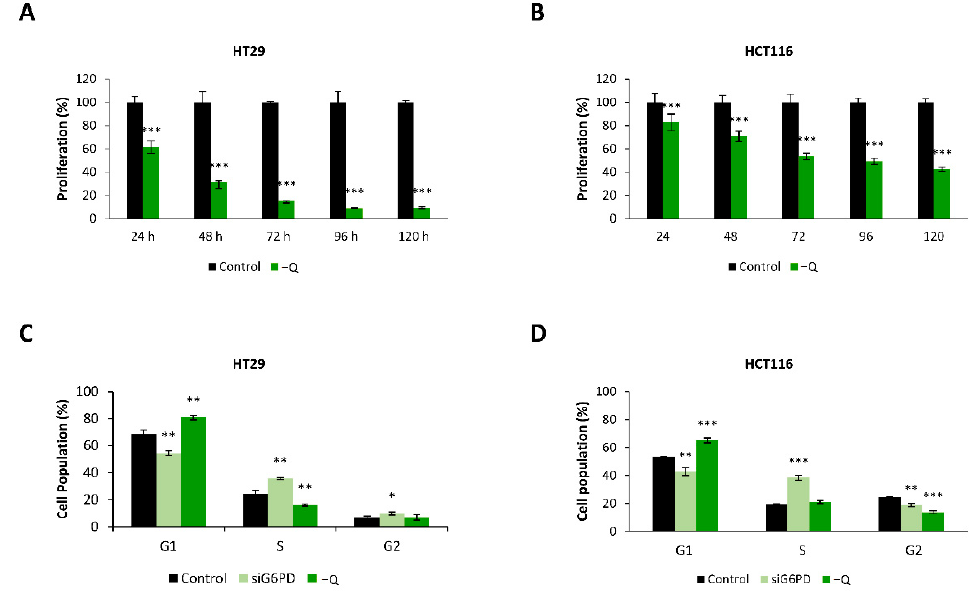
Figure 3. Glutamine deprivation decreased the proliferation of colon cancer cells and induced cell cycle arrest. ( A , B ) Proliferation rate of ( A ) HT29 cells and ( B ) HCT116 cells in control media and glutamine-free media ( − Q) at 24, 48, 72, 96, and 120 h. ( C , D ) Cell cycle distribution analysis of ( C ) HT29 and ( D ) HCT116 cells 96 h after transfection against G6PD or glutamine deprivation. The percentage of cells in the different cell cycle phases was calculated using FlowJo ® software. One asterisk (*) denotes p -value < 0.05, two asterisks (**) denote p -value < 0.01 and three asterisks (***) denote p - value < 0.001.